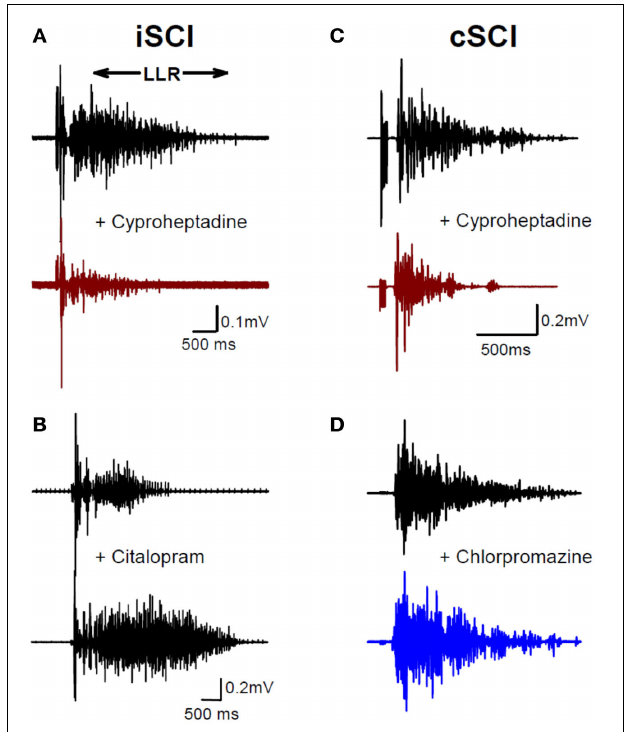
FIGURE 7 | Constitutive receptor activity in chronic human SCI. (A) Inverse agonist cyproheptadine in a motor incomplete SCI participant (iSCI, AIS C). Unrectified surface EMG during long-lasting reflex (LLR) evoked in the TA muscle from medial arch stimulation before (top trace) and after (bottom trace) 8mg of oral cyproheptadine. Note reduction in the presumably PIC-mediated long-lasting reflex (LLR: 500ms after stimulation onwards). (B) Serotonin re-uptake inhibitor citalopram in iSCI (AIS C) participant. Long-lasting reflex (LLR) recorded in TA muscle before (top trace) and after (bottom trace) 20mg of oral citalopram. (C) Same as in (A) but for 12mg oral dose of cyproheptadine in motor and sensory complete SCI participant (cSCI, AIS A). (D) Effect of neutral antagonist chlorpromazine (12.5mg) on PIC-mediated LLR in same cSCI participant. (A–C) taken from D’Amico et al.